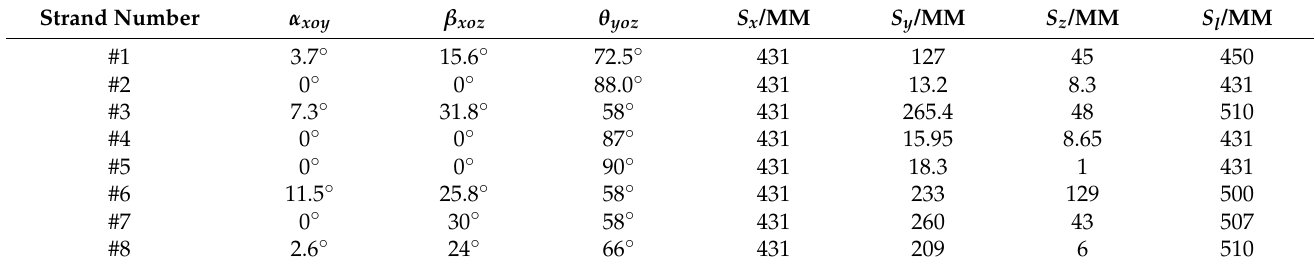
Figure 5. Position relation of each strand in y–z direction of the distribution reel. Table 1. The spatial relative position of each strand and the length in the co-ordinate